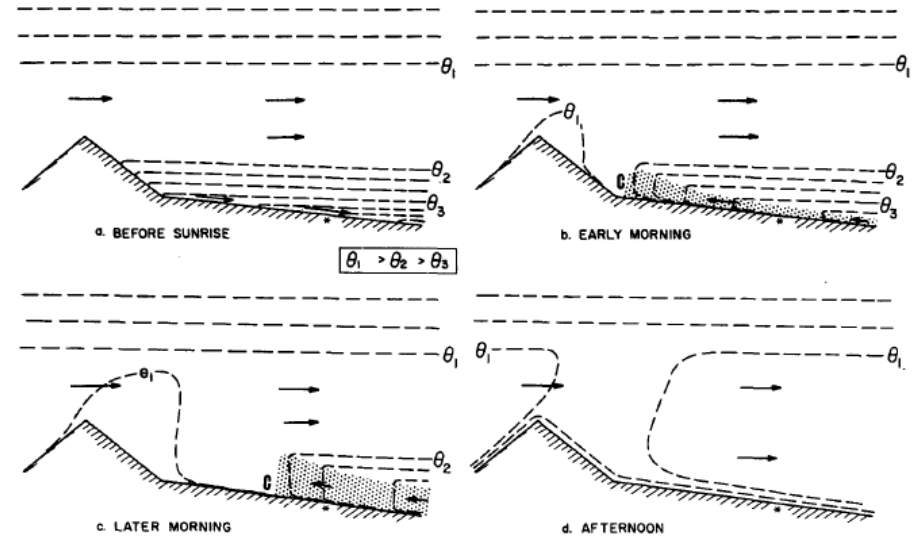
Figure 5. Schematic of diurnal flow development in the lee of a heated mountain, from Banta [42]. The cross-sections show potential temperature ( θ ) and cross-barrier winds in the: ( a ) nighttime, where both the ambient flow and sub-inversion flows are westerly, ( b ) early morning, where a shallow layer of easterly upslope flow develops below the inversion, ( c ) later morning, where the upslope flow deepens but is advected downstream by the background flow, and ( d ) the afternoon, where convective mixing eliminates the inversion and upslope flow. c (cid:13) American Meteorological Society. Used with